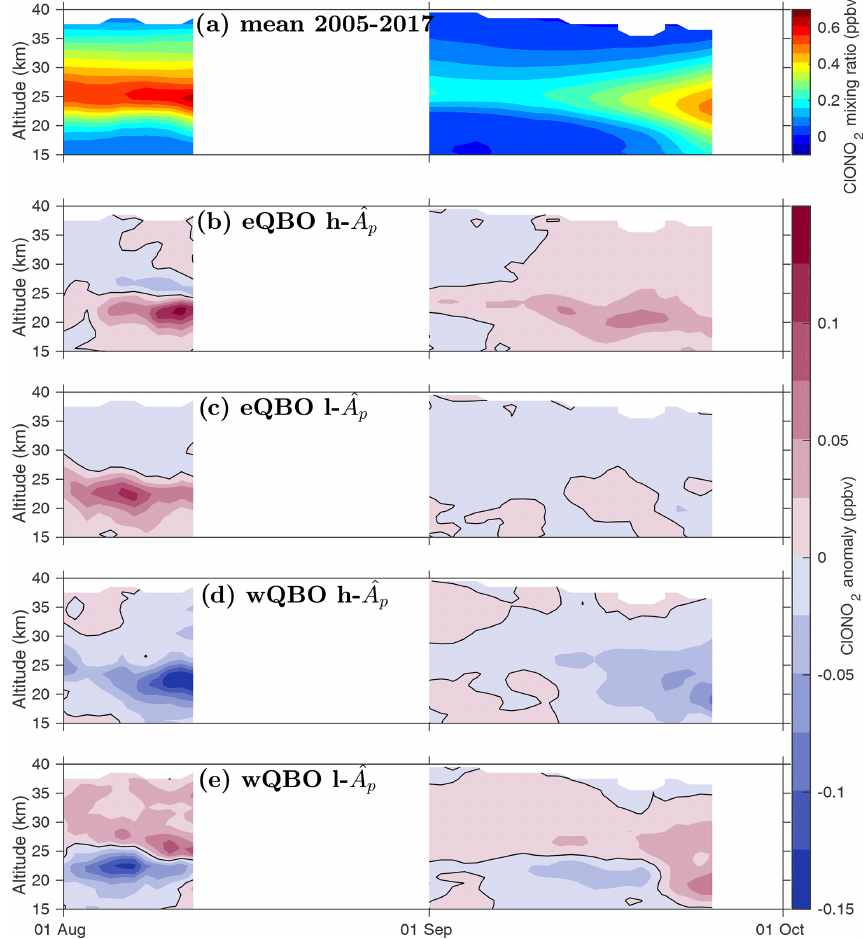
Figure 8. ACE-FTS ClONO 2 : (a) the composite mean for the 2005–2017 period for area-weighted observations poleward of 60 ◦ S. The y axis is the altitude from 15 to 40km ( ∼ 120–2hPa), and the x axis is the date from 1 August until 1 October. The contour interval is 0.1ppbv. (b) The anomaly from the mean for eQBO years with high (cid:99) Ap, (c) eQBO years with low (cid:99) Ap, (d) wQBO years with high (cid:99) Ap, and (e) wQBO years with low (cid:99) Ap. The axes are the same as panel (a) . The contour interval is 0.05ppbv, and the black line shows the zero